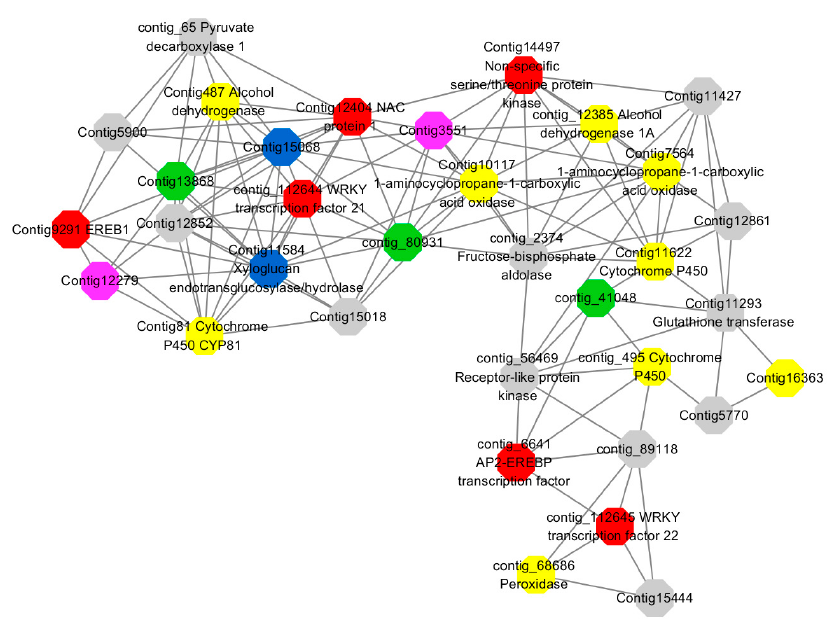
Figure 26. Interaction between genes in Module 3.